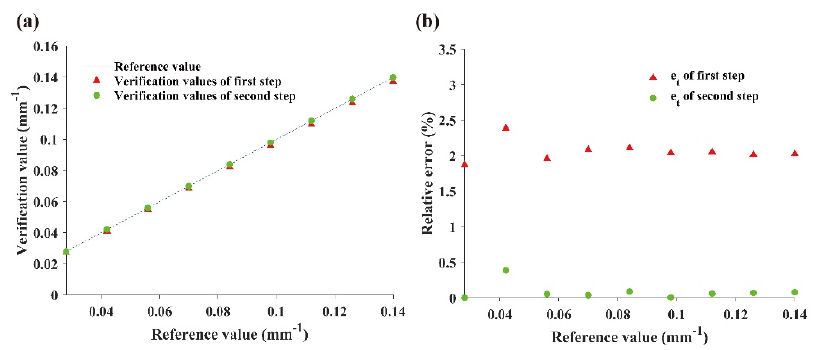
Figure 6. Calibration of projection frequency: ( a ) expected frequency and the two-step verification values; ( b ) percentage errors of two-step validation. values; ( b ) percentage errors of two-step